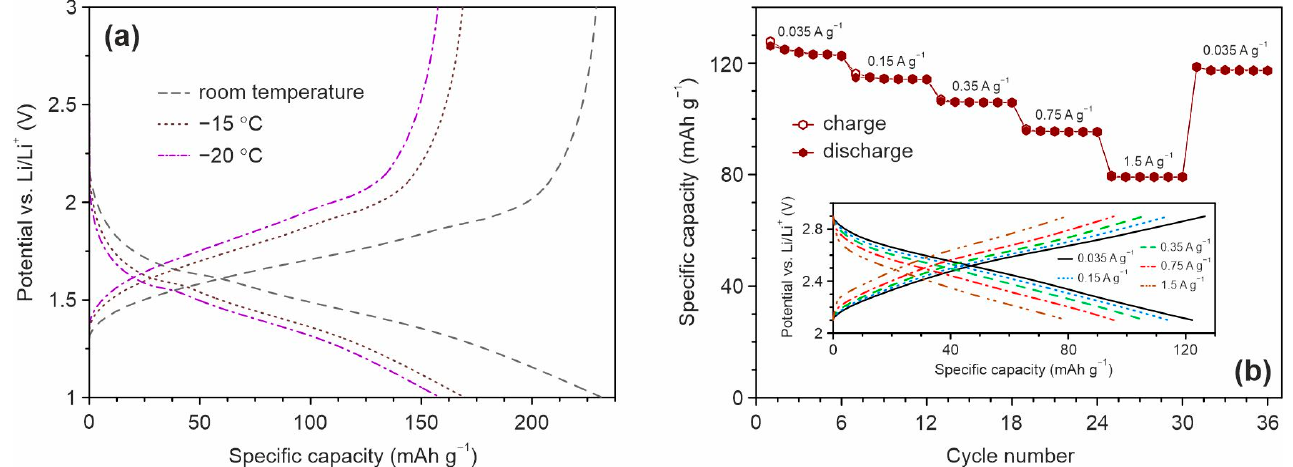
Figure 10. ( a ) Charge and discharge pro fi les for TO-Mn/F/N-04 electrode at room temperature, − 15 and − 20 °C registered at a current density of 70 mA g − 1 in the half-cell con fi guration and ( b ) rate capability studies (after pre-cycling CV experiments) of the TiO 2 (B)/LiMn 2 O 4 full-cell in the range of 2.1 and 2.9 V at various current densities with the corresponding charge/discharge pro fi les (inset).